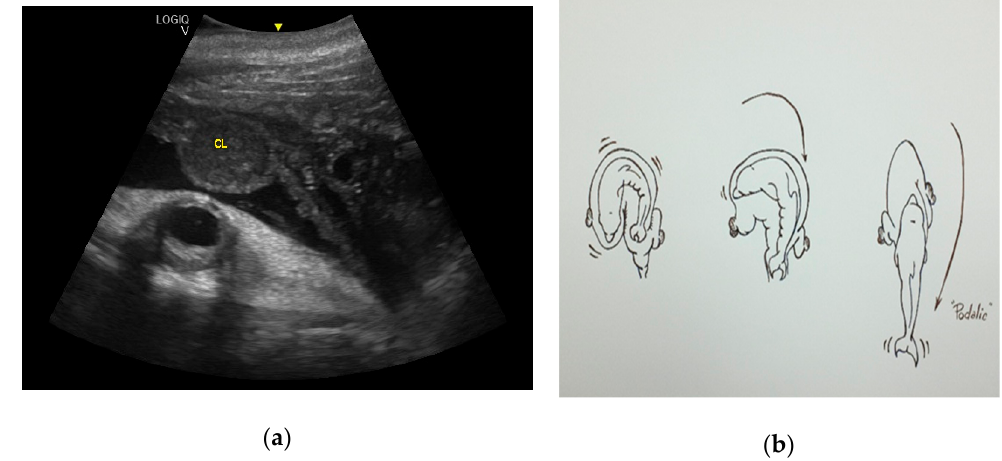
Figure 12. ( a ) Using the CL as a reference, if the fetus skull is located close to the CL, it will have a podalic position at birth, ( b ) as shown in the image.